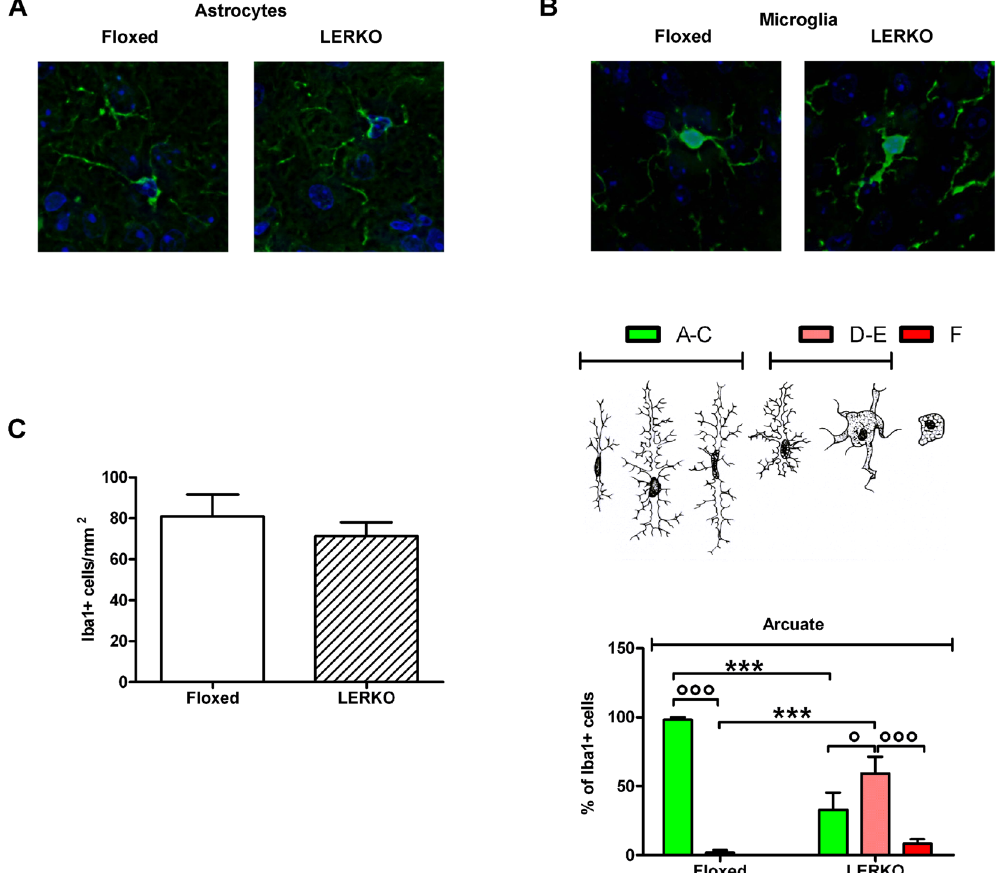
Figure 2. The absence of hepatic ER α affects the morphology of microglia, but not astrocytes. Representative images of astrocytes in the arcuate nucleus of floxed and LERKO mice stained with an anti-GFAP Ab ( A ), upper: representative images of microglia in the arcuate nucleus of FLOXED and LERKO mice at E stained with anti Iba1 Ab, middle: morphology of microglia at different stages of activation adapted from Kreutzberg et al ., Trends is Neuroscience (1996) 83 , lower: percentages of microglia distribution across different phenotypes ( B ), percentage of Iba1-positive cells in the different stages of microglia activation in the arcuate nucleus of FLOXED and LERKO mice at E ( C ). Data shown are the combined result of 2 separate experiments (n = 5 mice/group/ experiment). Data are represented as mean ± SEM. Figure 2B: °p < 0.05, °°°p < 0.001, *** p < 0.001, one-way ANOVA followed by Bonferroni post hoc test. p < 0.0001, DF = 2, F = 31.18 A–C vs D–E vs F, p = 1, DF = 1, F = 0 LERKO vs FLOXED, but the interaction between the two variables is significant (p < 0.0001). Figure 2C: p = 0.7855, DF = 17, t = 0.2765, two-tailed unpaired